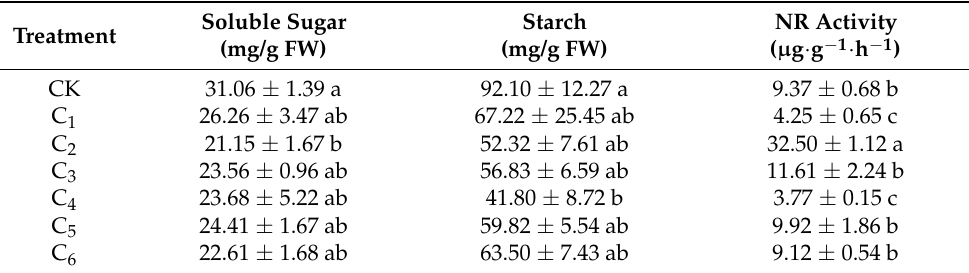
Table 5. The concentration of non-structure carbohydrate and nitrate reductase activity in the roots of S. sebiferum container seedlings with different biochar